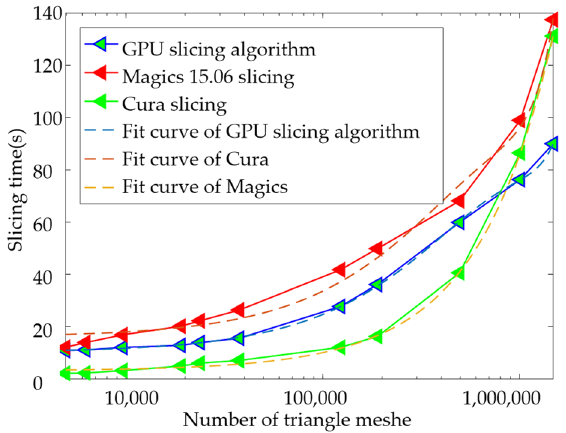
Figure 9. Hexagonal partition and scan filling of slice data.